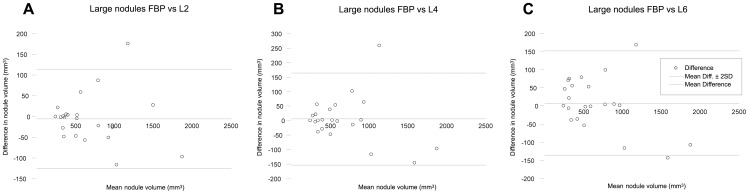
Agreement of large pulmonary nodule measurements.Bland-Altman plots of CT measured nodule volume at filtered back projection (FBP) and iterative reconstruction (iDose4 level 2 (A), 4 (B) and 6 (C)) for large nodules. The horizontal axis shows the mean value of the measured nodule volume with FBP and iterative reconstruction. The vertical axis shows the difference between the measured nodule volume with FBP and iterative reconstruction. FBP Filtered back projection; L2 Level 2; L4 Level 4; L6 Level 6.